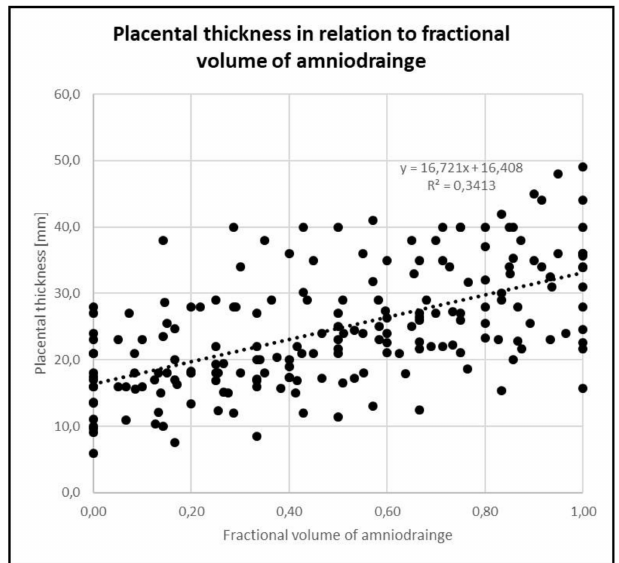
Figure 1. Intrauterine pressure (mmHg) in relation to fractional amniodrainage volume (0 to 1) following FLA. Data on intrauterine pressures (y) are presented as a function of fractional amniodrainage volume (x). The linear regression (broken line) is given as y = -11.7x + 29.6; R2 = 0.34, n = 10. Fractional amniodrainage volume is defined as drained volume at time point of measurement divided by total amniodrainage volume. Measurements were performed every 200 mL of amniodrainage. FLA: fetoscopic laser ablation.